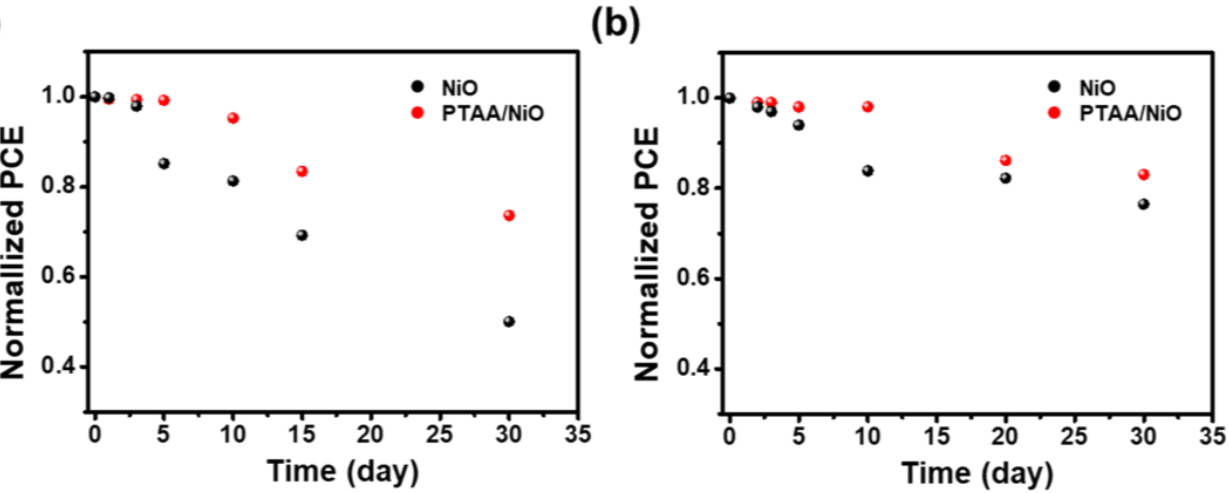
Figure 8. Stability of normalized PCE of NiO and PTAA/NiO bilayer devices ( a ) under air atmosphere at room temperature (unencapsulated); ( b ) under 85% RH/85°C temperature environment (encapsulated).